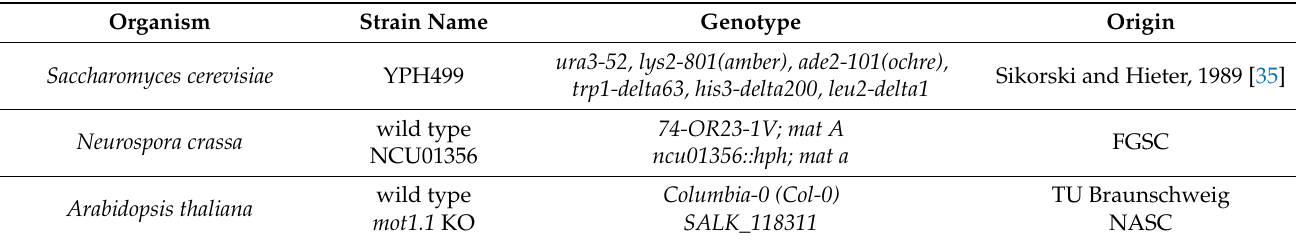
Table 1. Model organisms used in this